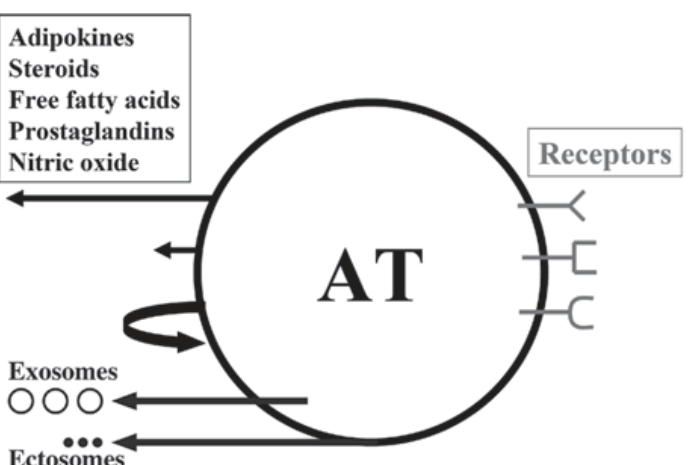
Figure 3. Schematic illustration of white adipose tissue (AT) as a multicrine organ. AT consists of adipocytes, fibroblasts, mast cells, macrophages and other immune cells.The arrows, left from up-to-down, indicate endocrine, paracrine and autocrine pathways; the other two arrows show the extracellular vesicles: exosomes and ectosomes. Depicted on the right are the adipose cell receptors for various ligands. From: [13] (reproduced with permission).